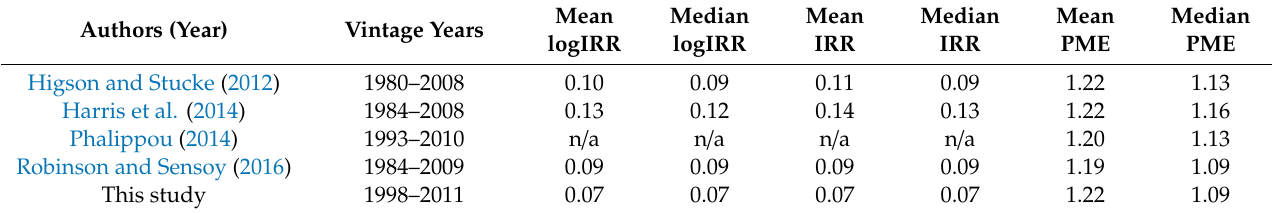
Table A2. Average private equity fund